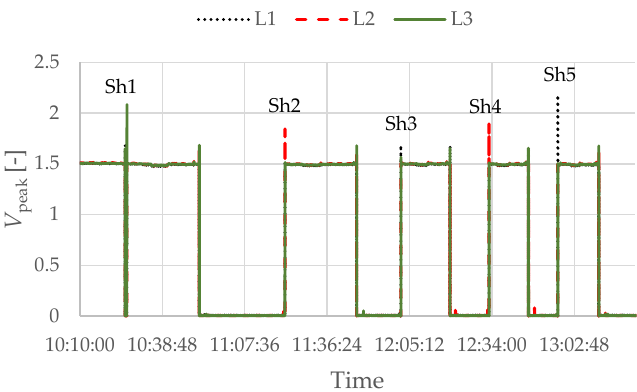
Figure 22. Peak voltages in cores registered at Substation 1. Circuit 1 cable line.